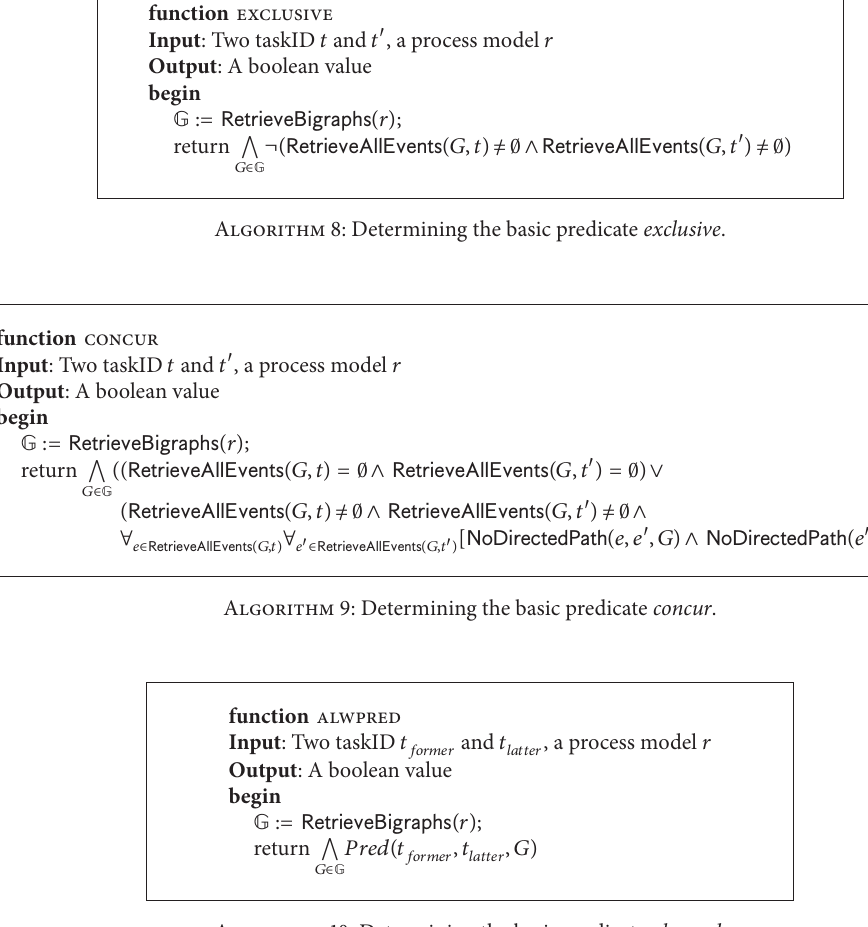
Algorithm 10: Determining the basic predicate alwpred .